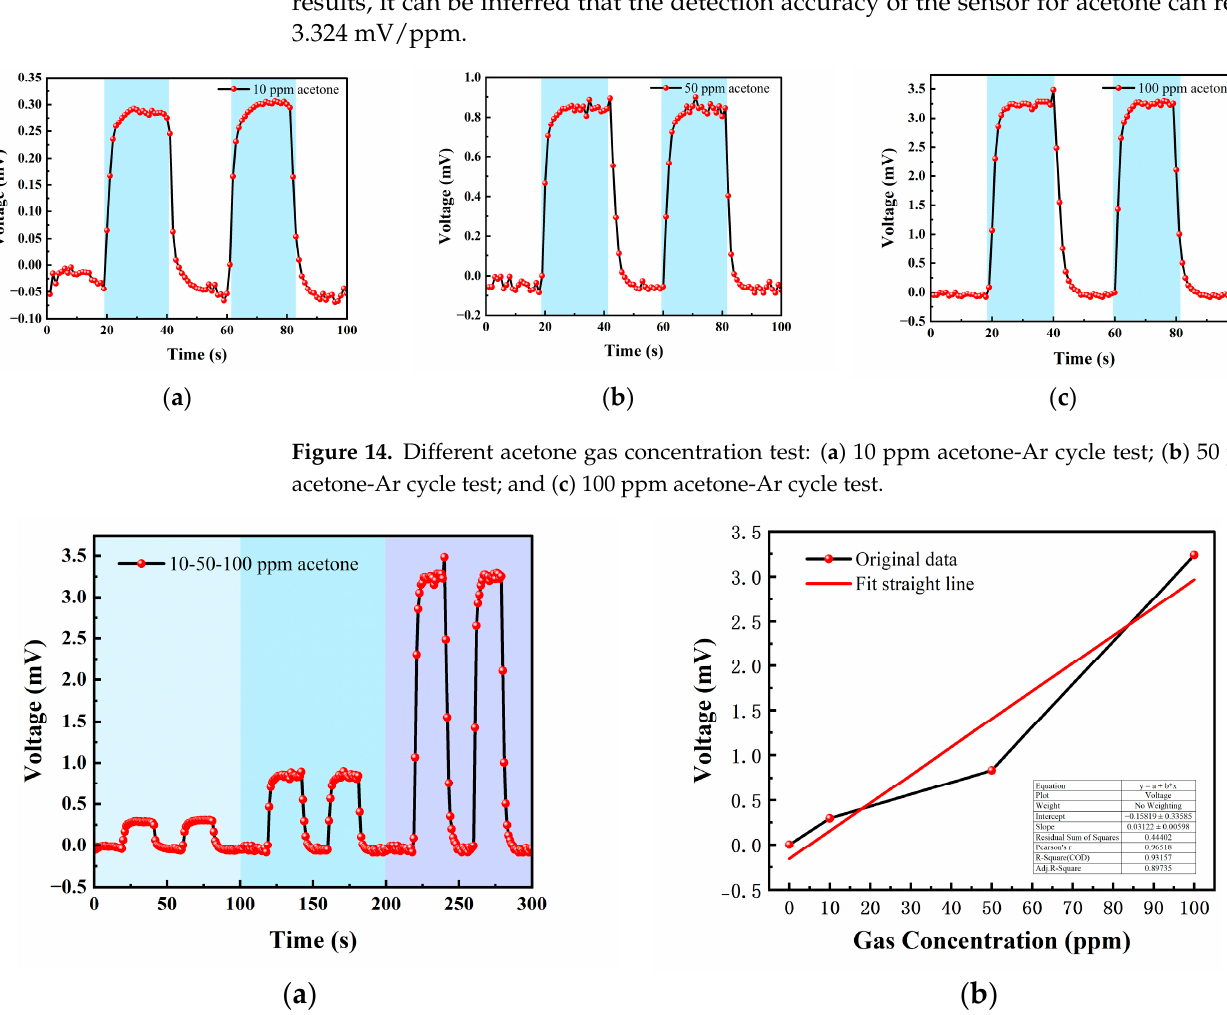
Figure 15. ( a ) 10, 50, 100 ppm acetone gas concentration test; ( b ) acetone gas concentration–voltage fitting straight line.